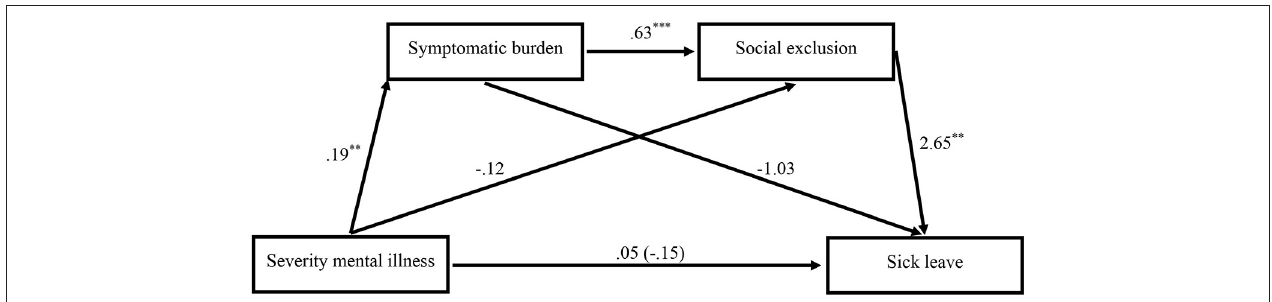
FIGURE 2 | Mediation model showing the impact of the severity of the mental illness on sick leave via the symptomatic burden and social exclusion ( n = 82). The total effect of the severity of the mental illness on sick leave without controlling for the symptomatic burden and social exclusion is shown in parentheses. Unstandardized regression coefficients. Two-sided testing of significance. ** p < 0. 01, *** p < 0.001.